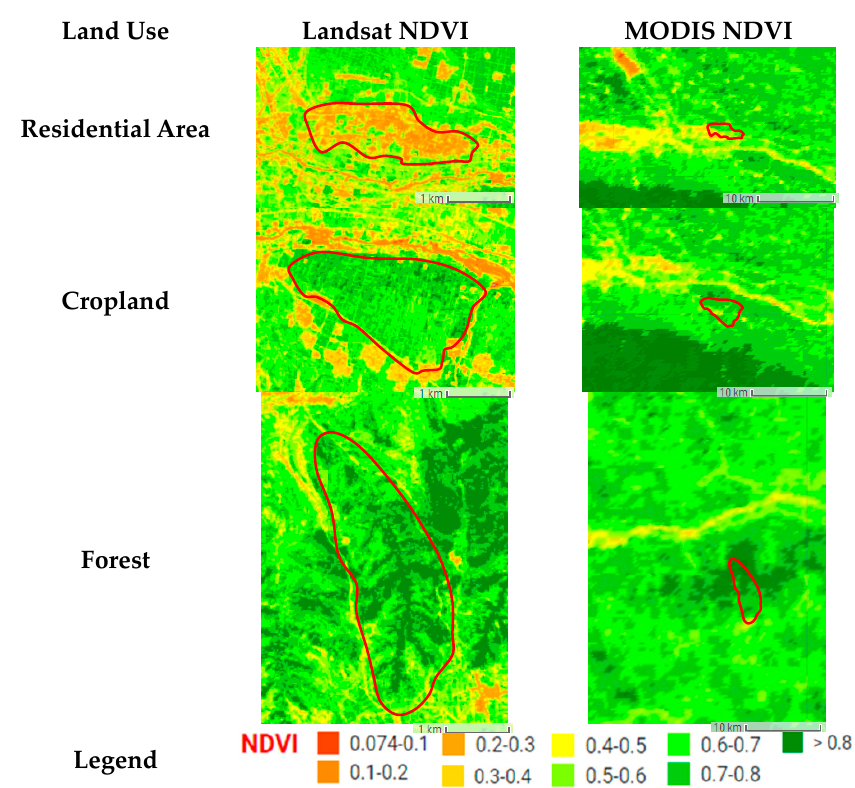
Figure 12. The comparison diagram of spatial distribution of Landsat NDVI and MODIS NDVI (2010).